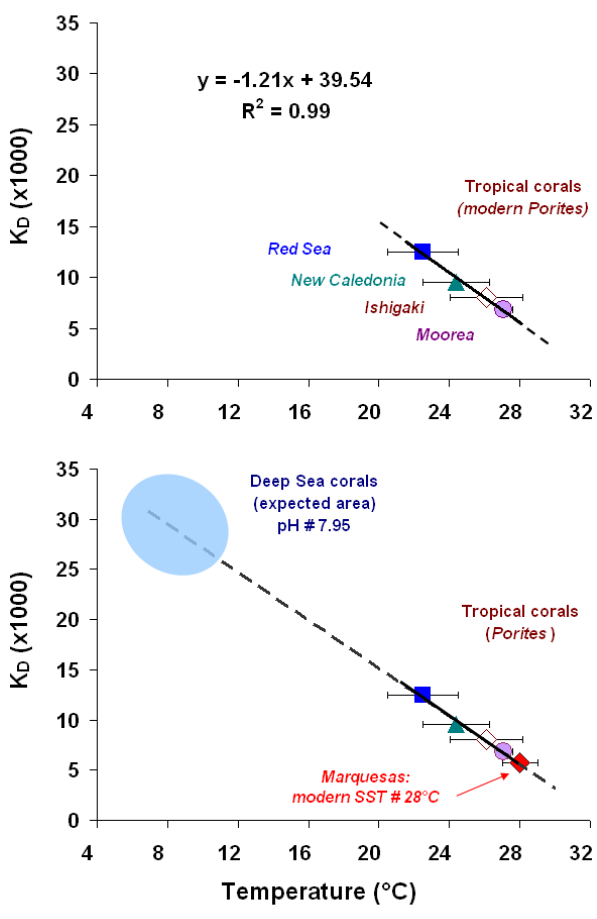
Fig. 6. Linear correlation between the mean regional SST and the partition coefficient K D obtained from modern Porites samples col- lected from various SST areas. This regression shows the influence of the temperature on K D and is valid for various aragonite species. The tropical corals are Porites, Acropora , and the cold sea coral is Lophelia pertusa . The expected area for cold sea corals (6–11 ◦ C) was determined from pH 7.95 and from the high boron concentra- tions (78–100ppm) measured in North Atlantic Lophelia pertusa samples collected between 40 ◦ N and 70 ◦ N (Douville et al.,